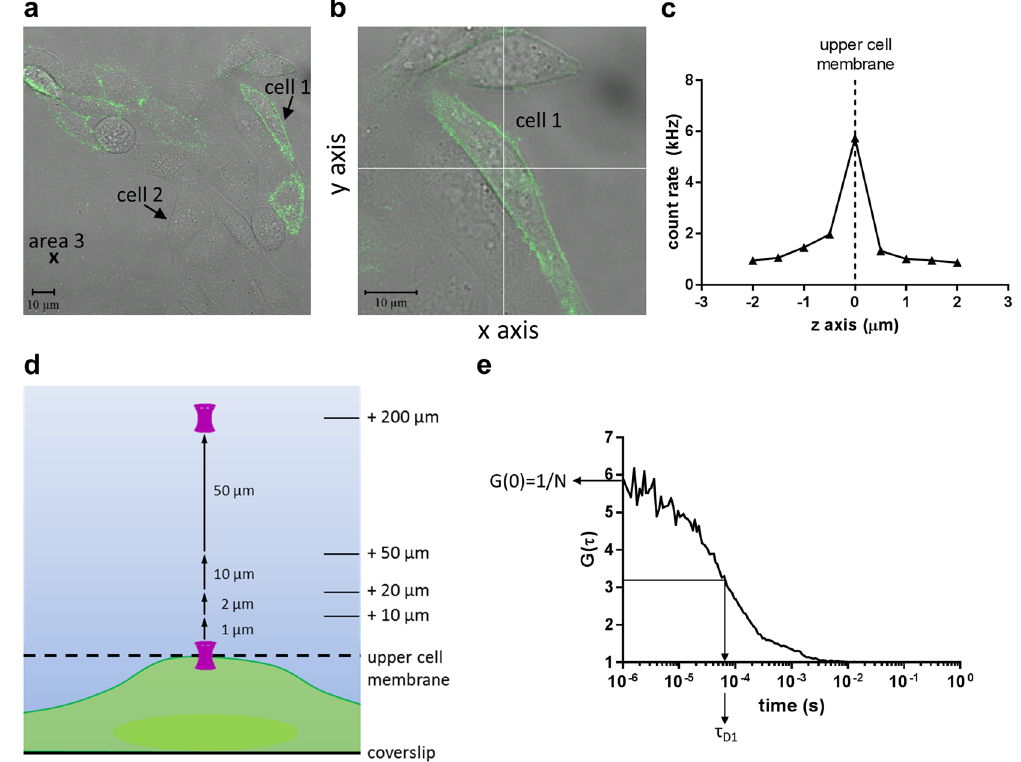
Figure 1. FCS experimental set-up used in this study. ( a ) Confocal image of receptor expressing (cell 1) and non-receptor expressing (cell 2) CHO- β 2 GFP cells, and control areas of no cell (area 3) used for FCS measurements. ( b ) Crosshair placement over the nucleus of a single cell was used to define the positioning of the FCS confocal volume in the x-y plane. ( c ) Detection of BY-propranolol fluorescence intensities in the z dimension allowed localisation of the upper cell membrane. ( d ) Schematic representation of confocal volume positions covering a range of distances from 2–200 µ m above the upper membrane of a single cell in 1, 2, 10 and 50 μ m steps. ( e ) Determination of particle number (N) and dwell time ( τ D1 ) to quantify concentration and diffusion coefficient of BY-propranolol from its FCS autocorrelation